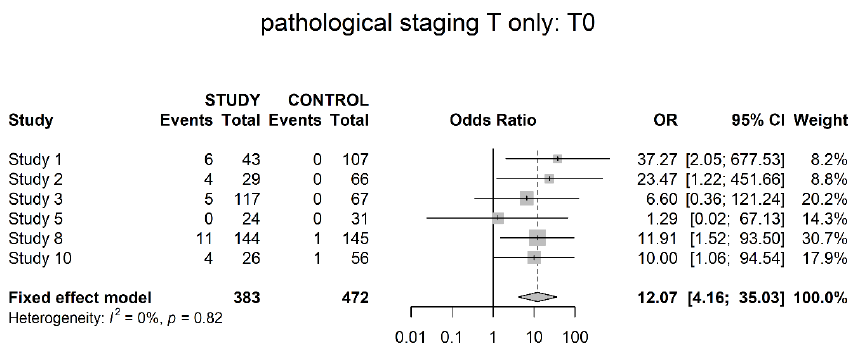
Table 2. Descriptive presentation of patient